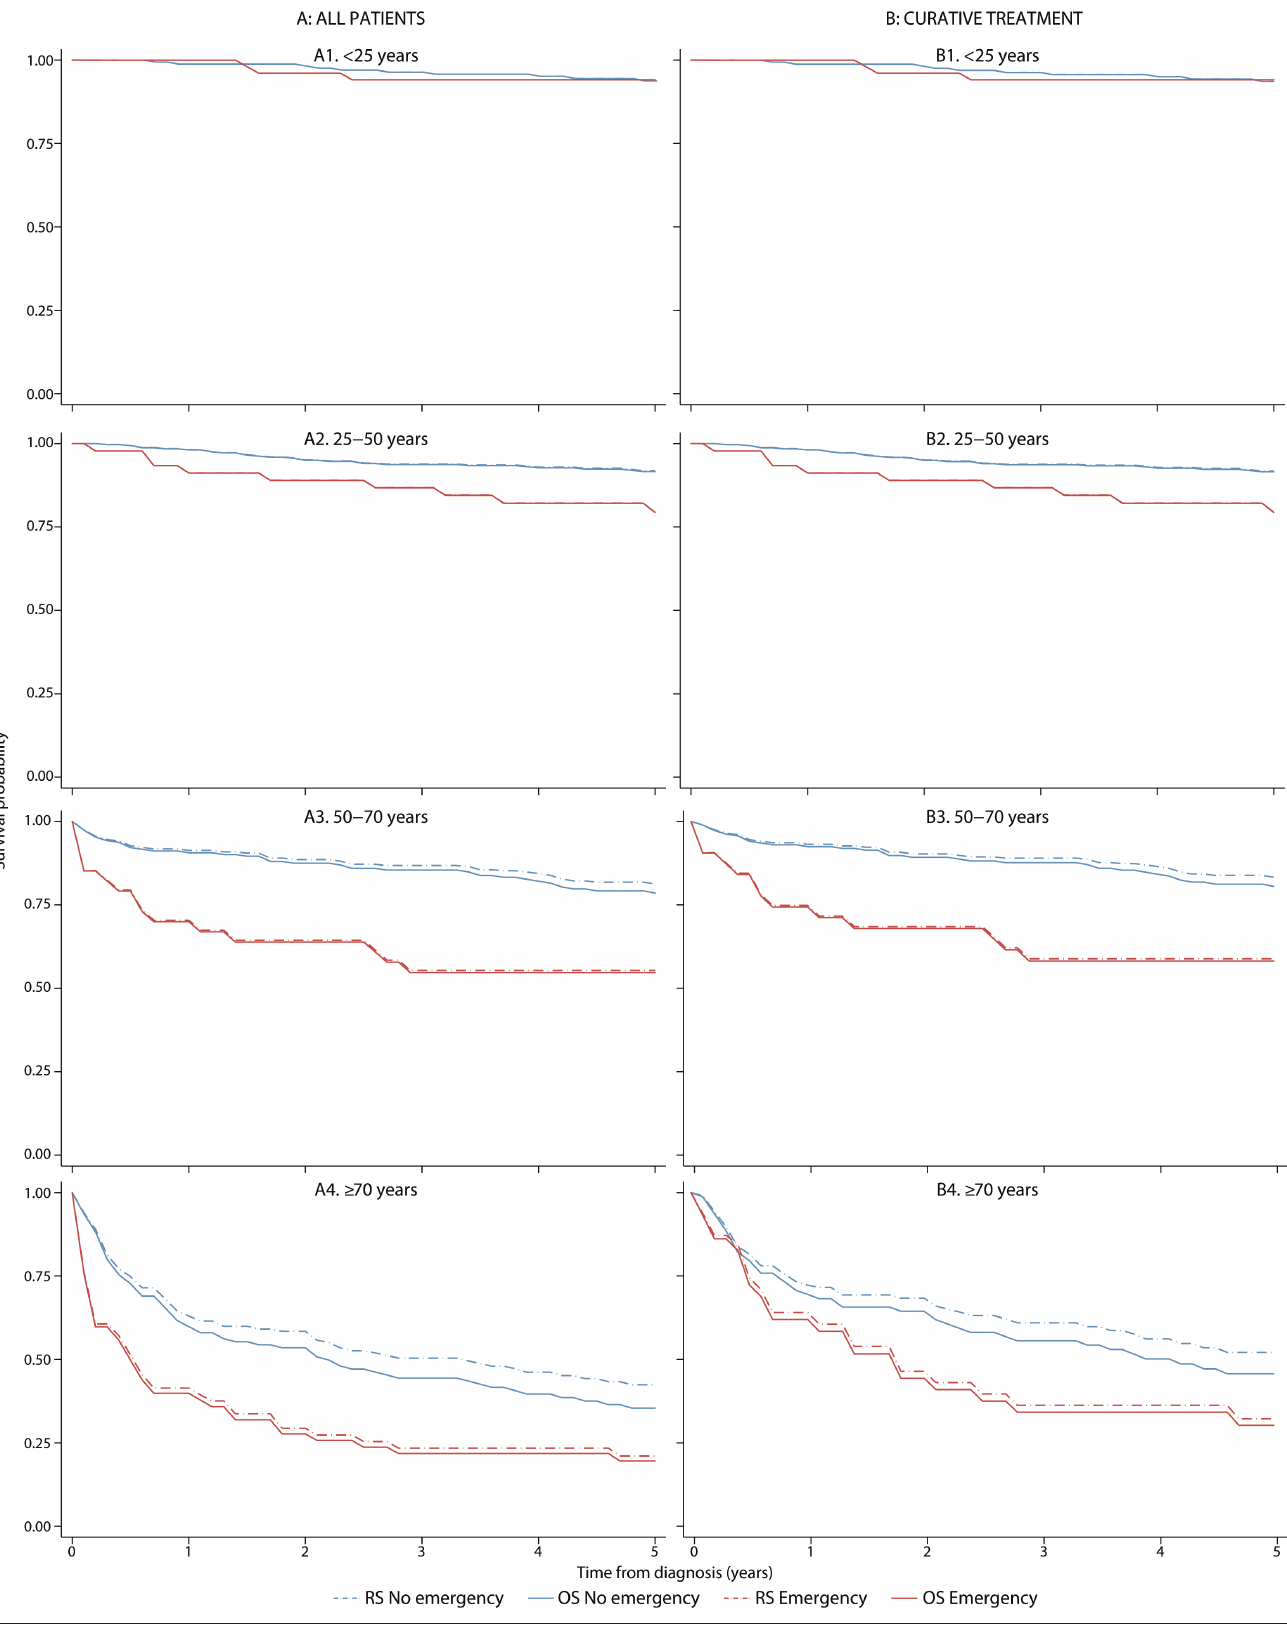
Figure 2 Classical Hodgkin lymphoma overall survival (OS) and relative survival (RS) curves for all patients (A) and those treated with curative intent (B), stratified by emergency admission status and age (data from Haematological Malignancy Research Network diagnoses